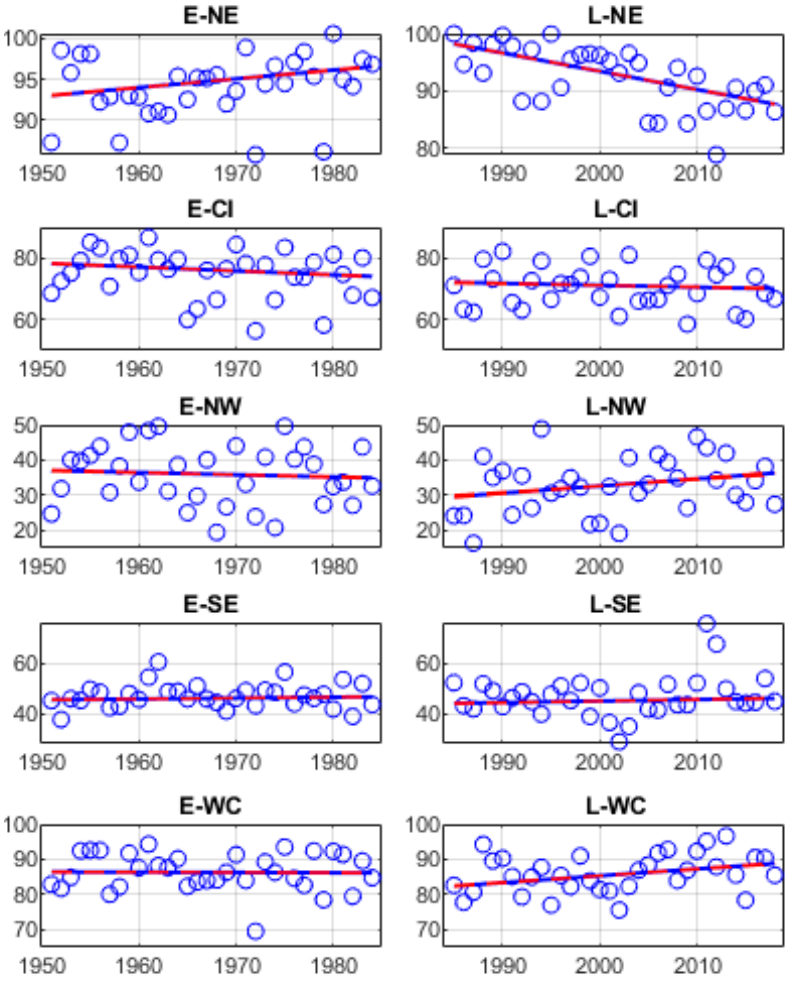
Figure 3. MK test for the number of rainy days over five homogenous regions of India North West (NW), Central India (CI), North East (NE), West Coast (WC), South East (SE)]. On each panel prefix, “E” means, data considered from 1951 to 1984, while prefix “L” means, data consideration from 1985 to 2018. The blue line shows the trend, while the red dotted lines show confidence at a 95% significance level here.